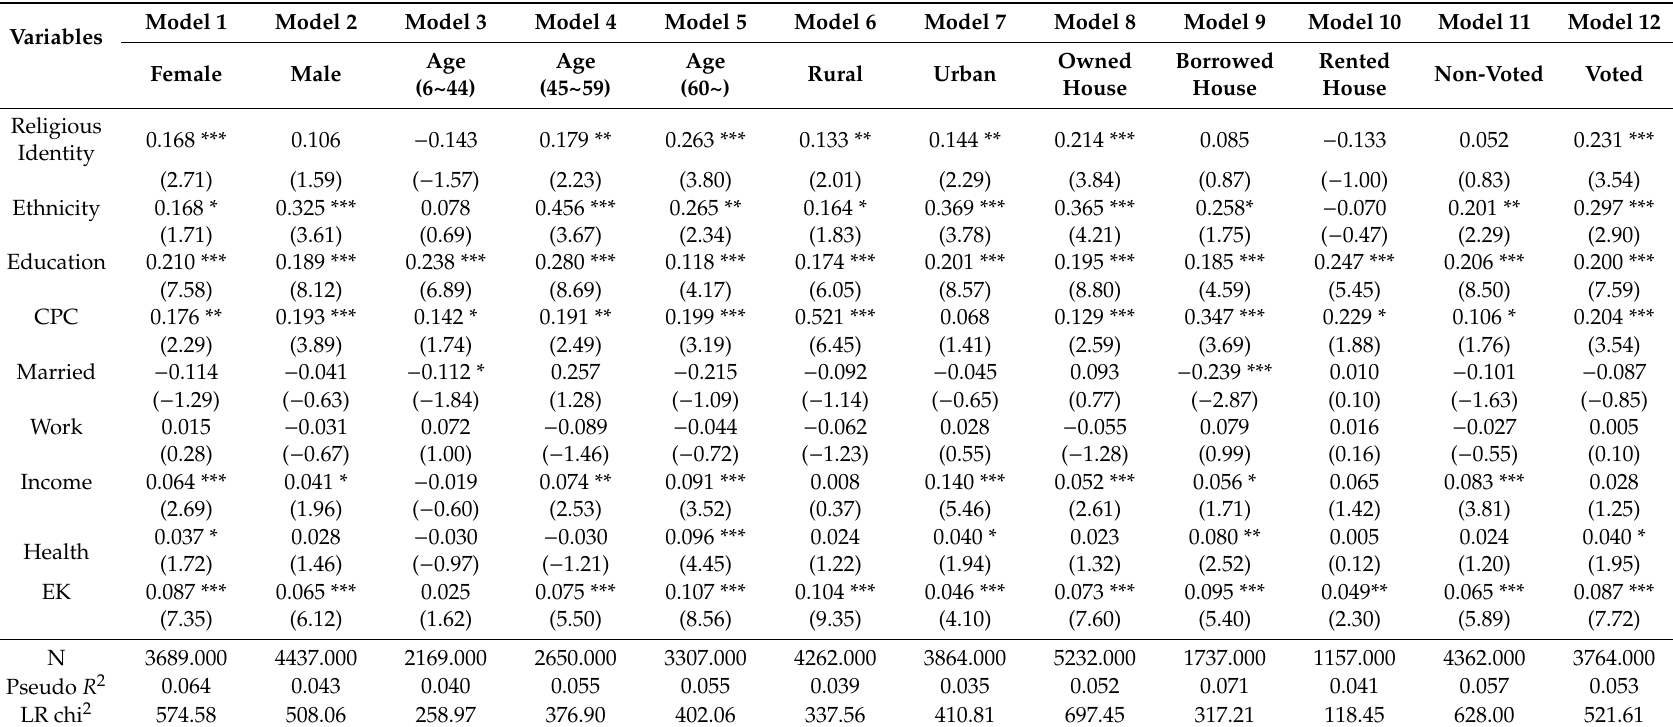
Table 2. Ordered Probit Regression of religious identity on public pro-environmental behavior in di ff erent